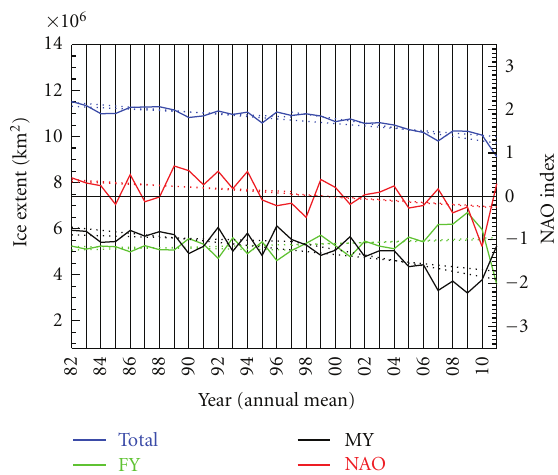
Figure 14: Time series of Arctic first-year sea ice extent, multiyear sea ice extent, and total (first-year plus multiyear) sea ice extent, and NAO index over the period 1982–2011 for the Arctic region north of 60 ◦